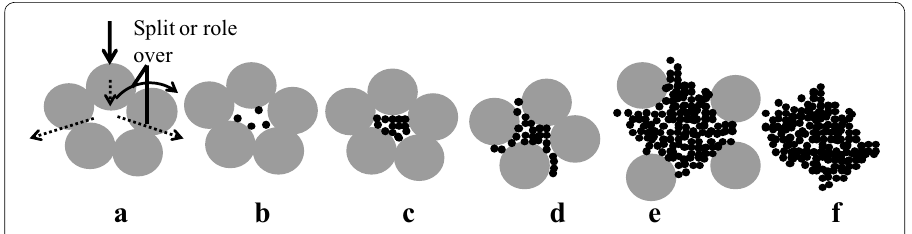
Fig. 28 Probable structure of sand–silt mixtures at